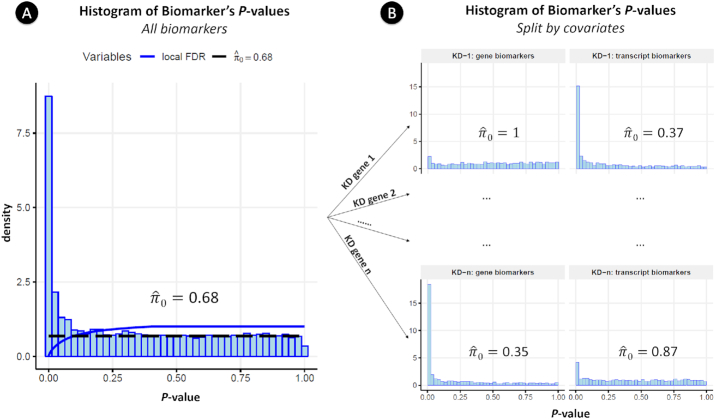
(A) Histogram of P-values of all tests (both genes and transcripts) taken together. The local FDR and the \documentclass[12pt]{minimal}
\usepackage{amsmath}
\usepackage{wasysym}
\usepackage{amsfonts}
\usepackage{amssymb}
\usepackage{amsbsy}
\usepackage{upgreek}
\usepackage{mathrsfs}
\setlength{\oddsidemargin}{-69pt}
\begin{document}
}{}${\hat{\pi }_0}$\end{document} (the proportion of true null hypotheses) values are shown. (B) Histogram of P-values after splitting by the covariates. The complete histogram in panel A gathers all the histograms in panel B. The covariates are, by rows: the KD genes; and, by columns: whether the biomarker is a gene or a transcript. In KD gene 1, transcripts are better biomarkers than genes (\documentclass[12pt]{minimal}
\usepackage{amsmath}
\usepackage{wasysym}
\usepackage{amsfonts}
\usepackage{amssymb}
\usepackage{amsbsy}
\usepackage{upgreek}
\usepackage{mathrsfs}
\setlength{\oddsidemargin}{-69pt}
\begin{document}
}{}${\hat{\pi }_0} = 0.37\,{\rm{vs}}\,{\hat{\pi }_0} = 1$\end{document}), and vice versa in KD gene n (\documentclass[12pt]{minimal}
\usepackage{amsmath}
\usepackage{wasysym}
\usepackage{amsfonts}
\usepackage{amssymb}
\usepackage{amsbsy}
\usepackage{upgreek}
\usepackage{mathrsfs}
\setlength{\oddsidemargin}{-69pt}
\begin{document}
}{}${\hat{\pi }_0} = 0.35\,{\rm{vs}}\,{\hat{\pi }_0} = 1$\end{document}).